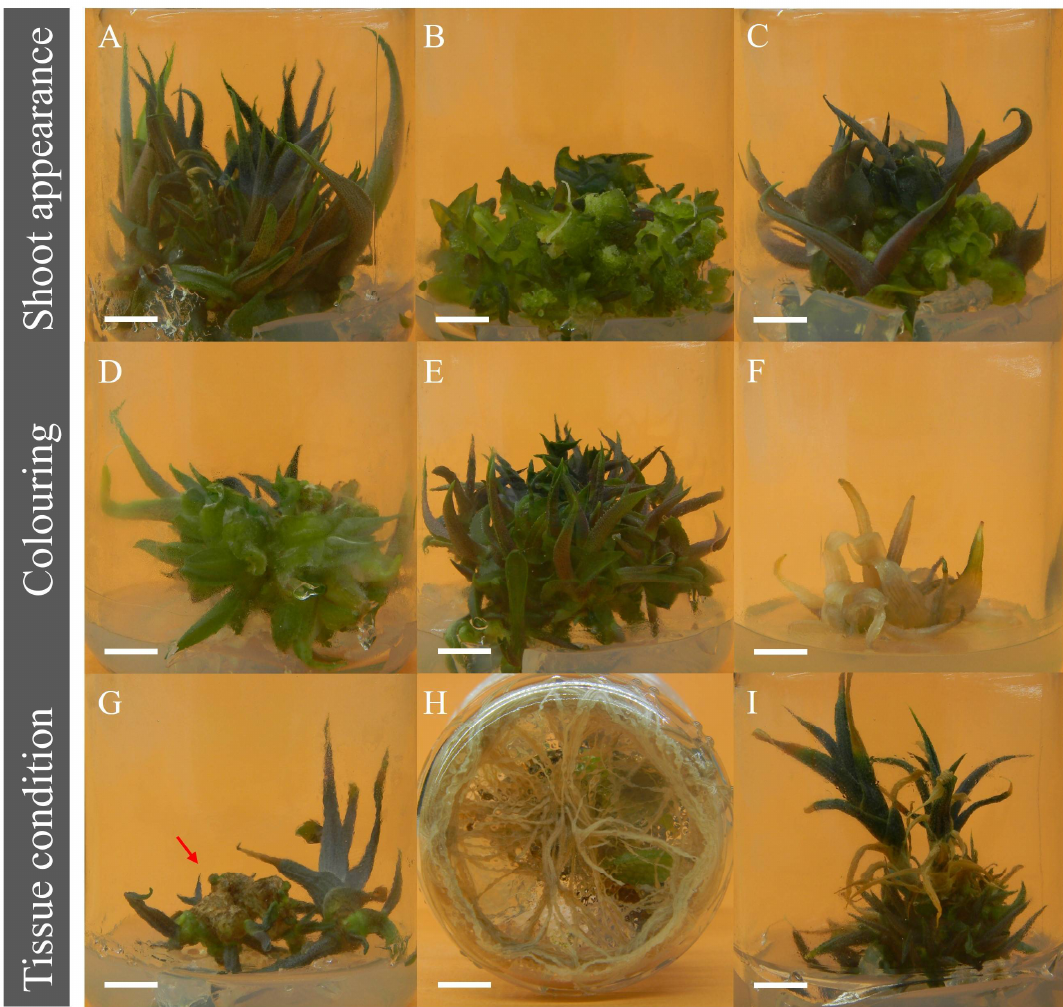
Figure 2. Seedling responses to MS+BAP (at 22.2 µM) for clonal line selection. Shoot appearance: